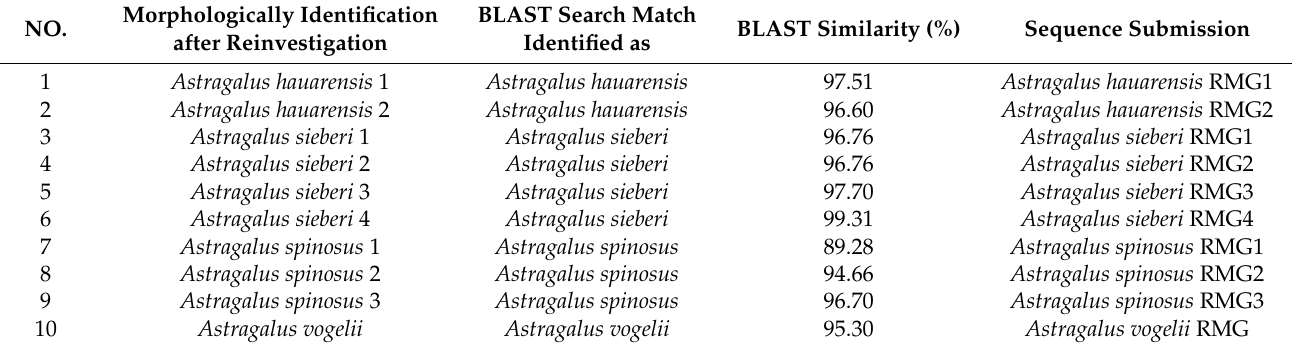
Table 7. BLAST Database search match for similarities using ITS2 gene